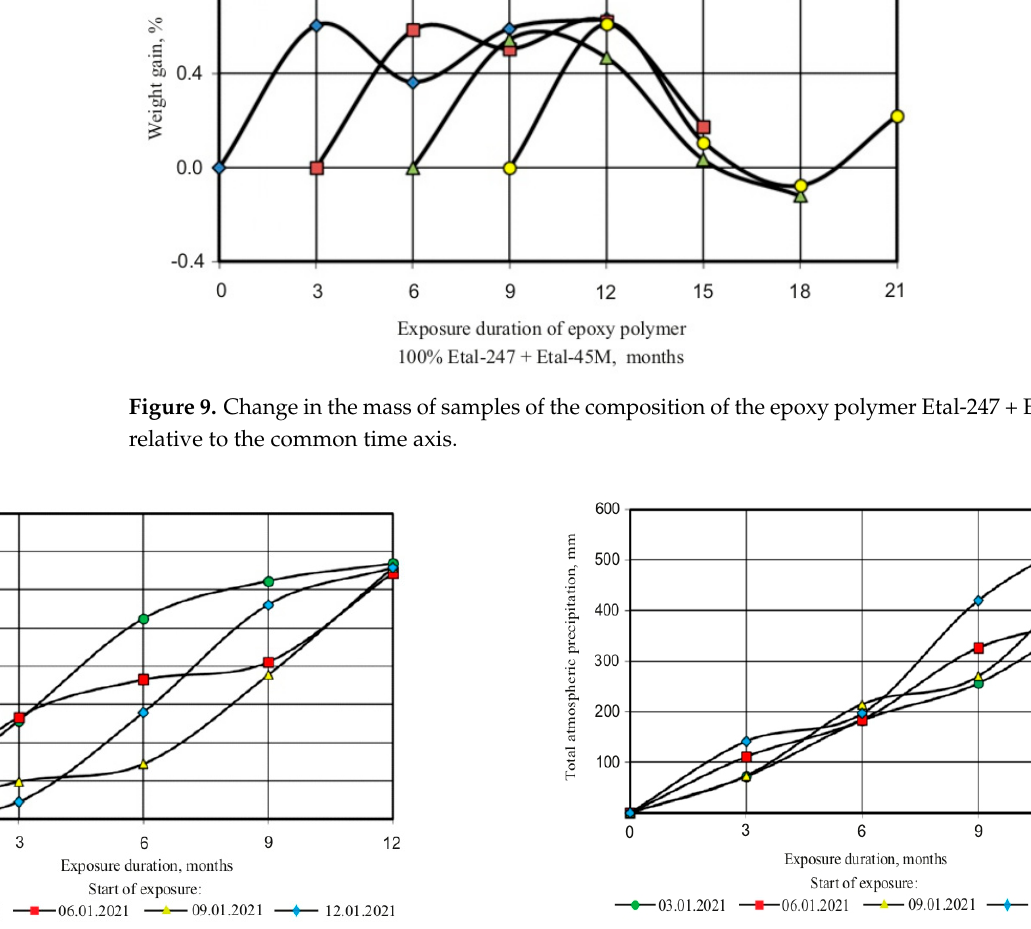
Figure 10. Changes in the total solar radiation ( a ) and total precipitation ( b ) depending on the season